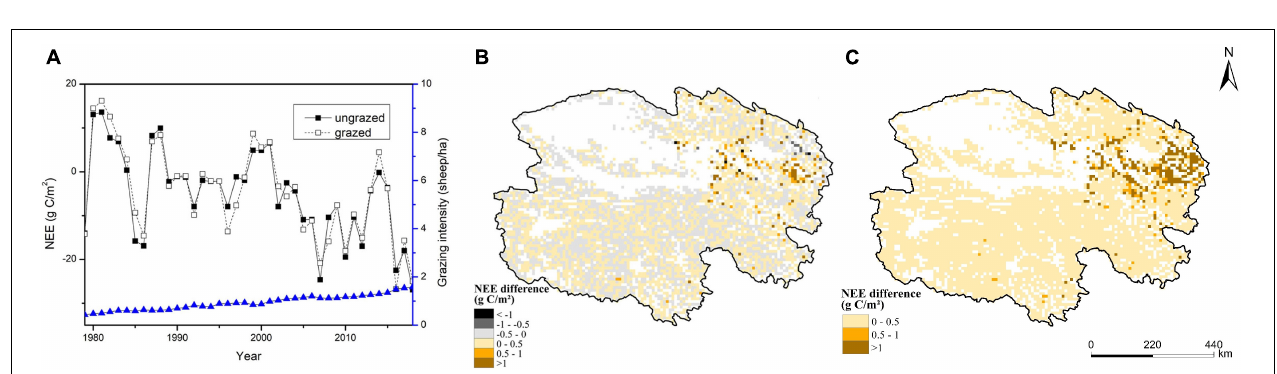
FIGURE 6 | Effect of grazing on the temporal (A) and spatial (B) dynamics of NEE and the map of the standard deviation of NEE difference (C) in Qinghai grasslands from 1979 to 2018 (NEE difference indicates the average annual difference between the grazed and ungrazed scenarios from 1979 to 2018).